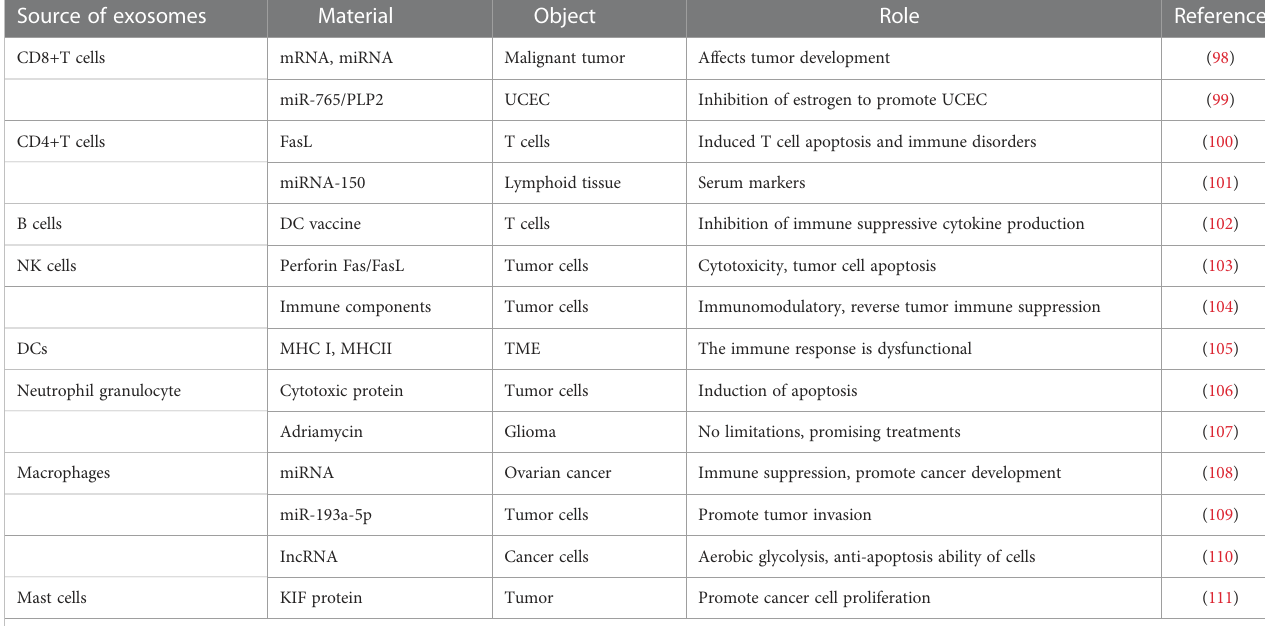
Source of exosomes